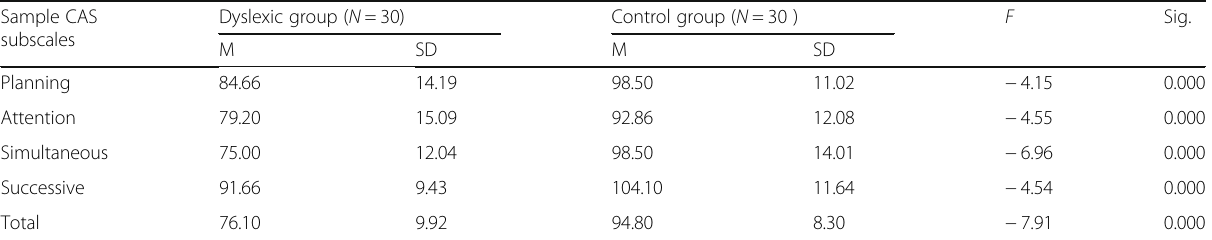
Table 6 Cognitive Assessment System: dyslexic vs. controls (early adolescence) Sample CAS